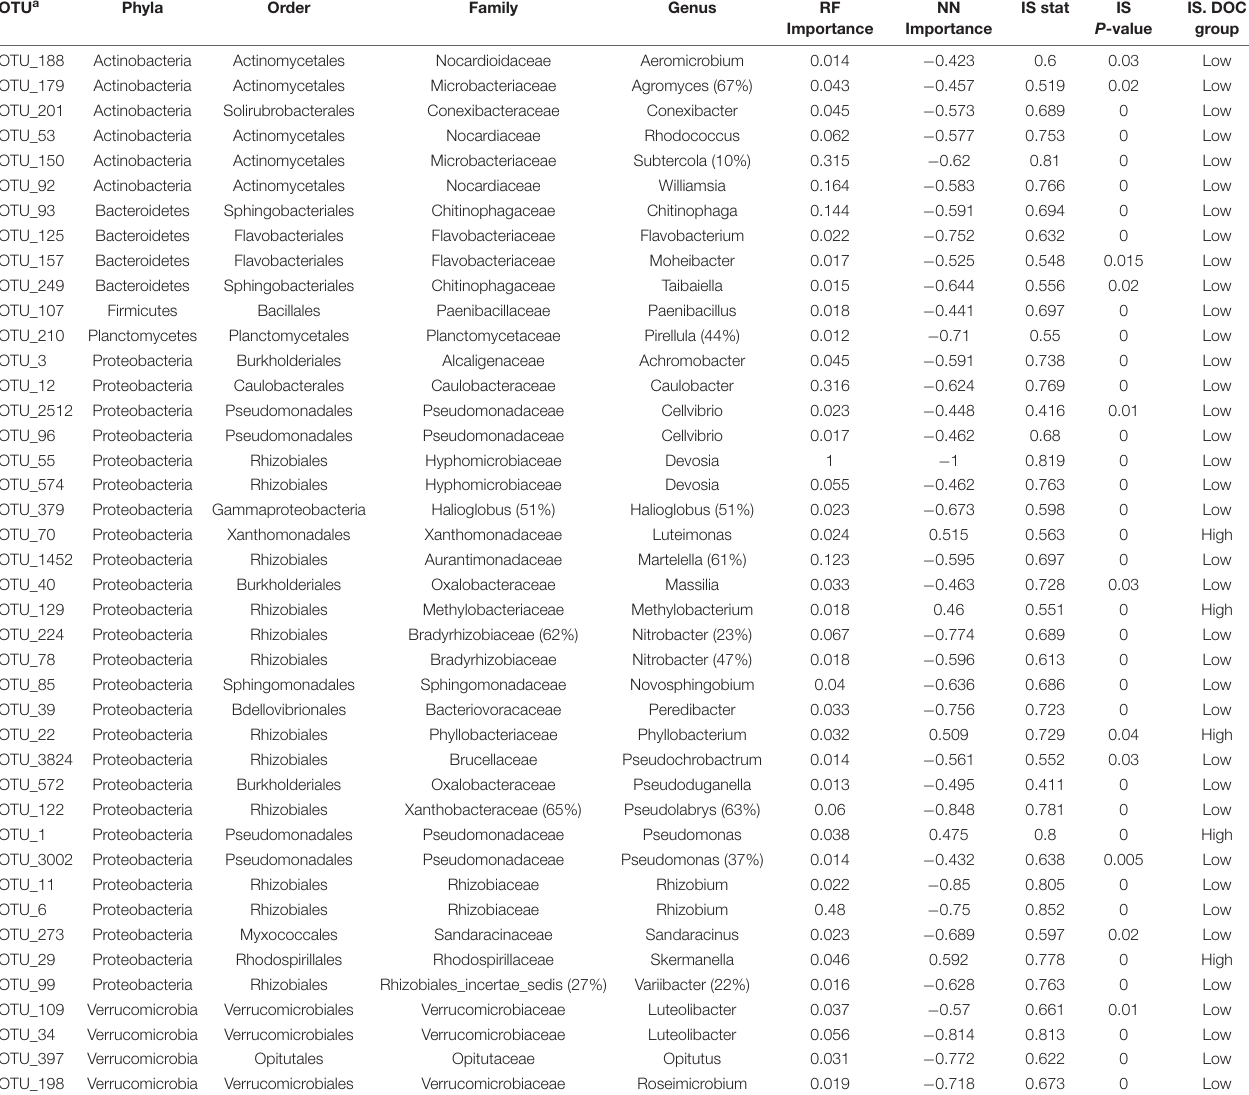
TABLE 1 | Forty-two bacterial taxonomic features consistently associated with DOC concentration in random forest (RF), neural network (NN), and indicator species (IS) analyses ( n = 349). OTU